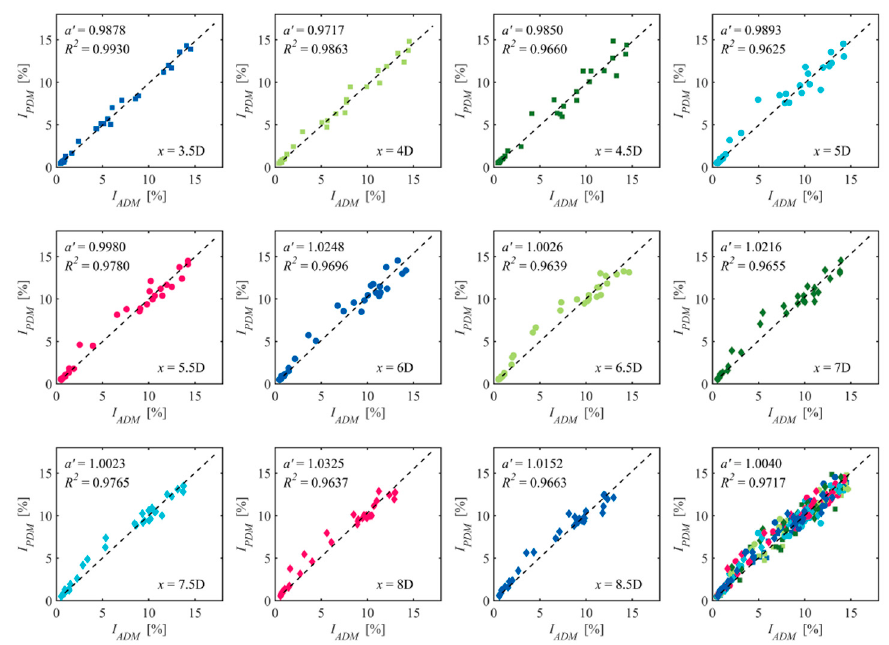
Figure 14. Relationship between the driving modes under the UIF condition in terms of the wake turbulence intensity.